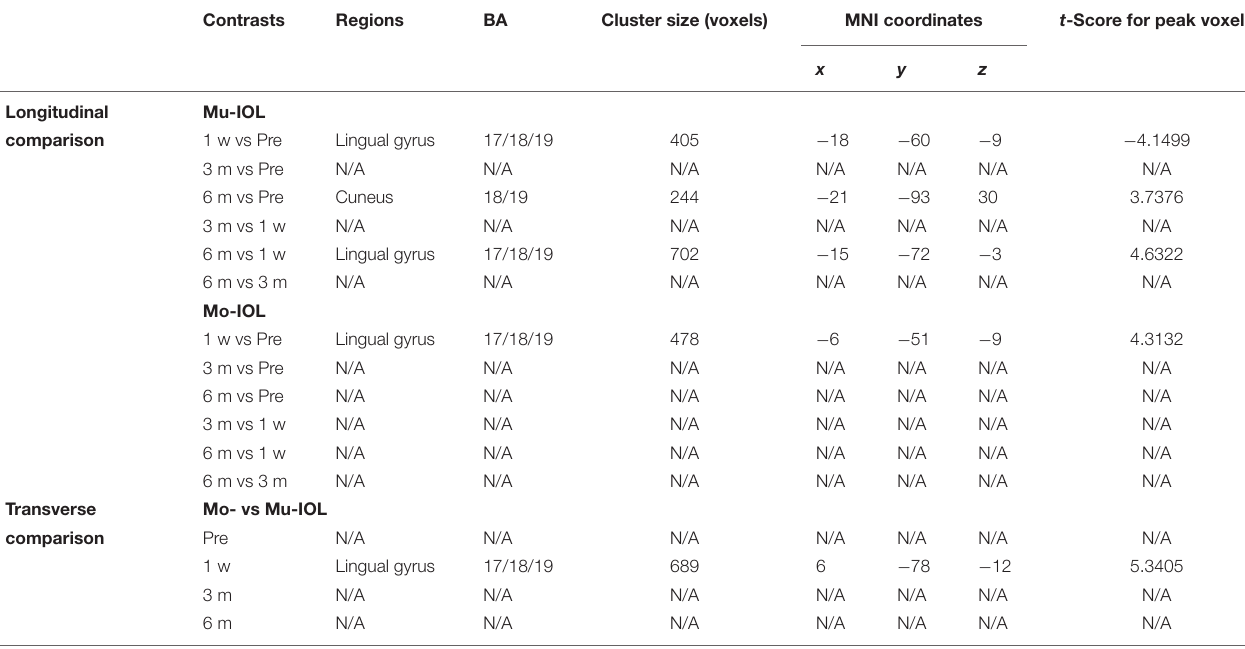
TABLE 2 | Comparison of fALFF values (visual cortex) after surgery in the Mu- and Mo-IOL